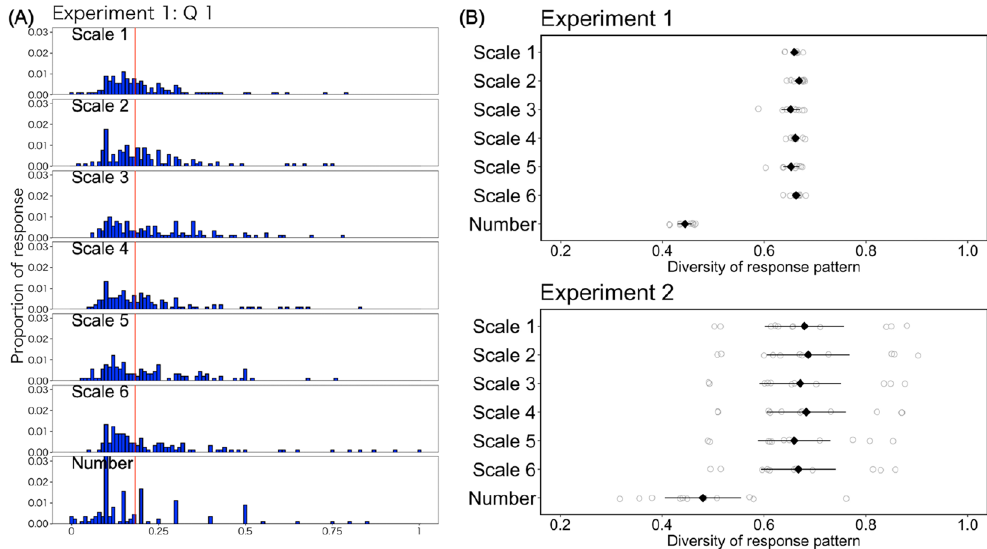
Figure 4. ( A ) Example of response distributions. These histograms were the results for Question 1 in Experiment 1. In making the histogram, each response was rescaled onto a 0 (minimum value in response) to 1 (maximum value in response) scale with 0.01 for bin width. The red line indicates the correct value. ( B ) Diversity of response patterns. Grey dots demonstrate diversity values for each question (nine questions in Experiment 1 and 11 questions in Experiment 2). Black dots demonstrate the means of the diversity values in each group, and the error bars show a 95% confidence